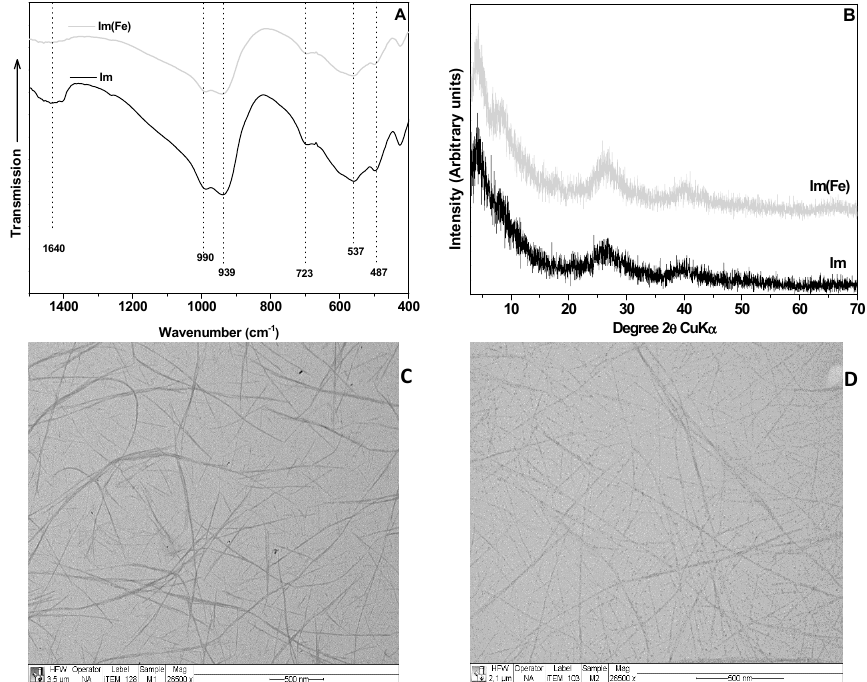
Figure 2. ( A ) Fourier transform infrared spectroscopy (FTIR) spectra of Im and Im(Fe); ( B ) X-ray diffraction (XRD) pattern of Im and Im(Fe); ( C ) Transmission electron microscopy (TEM) micrograph of Im; ( D ) TEM micrograph of Im(Fe).